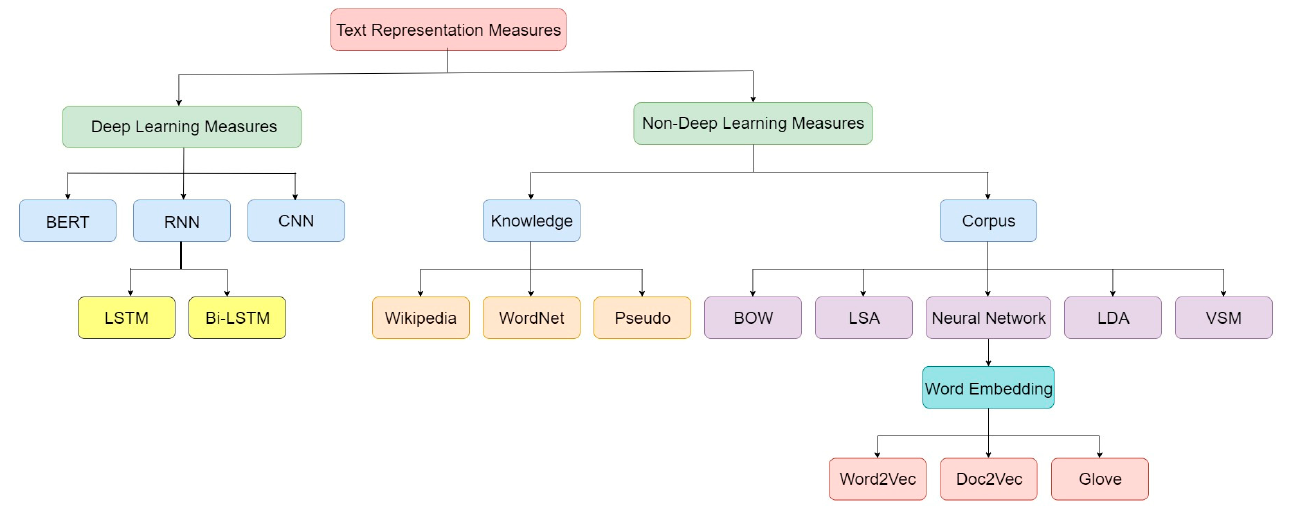
Figure 7. Main taxonomies for short text